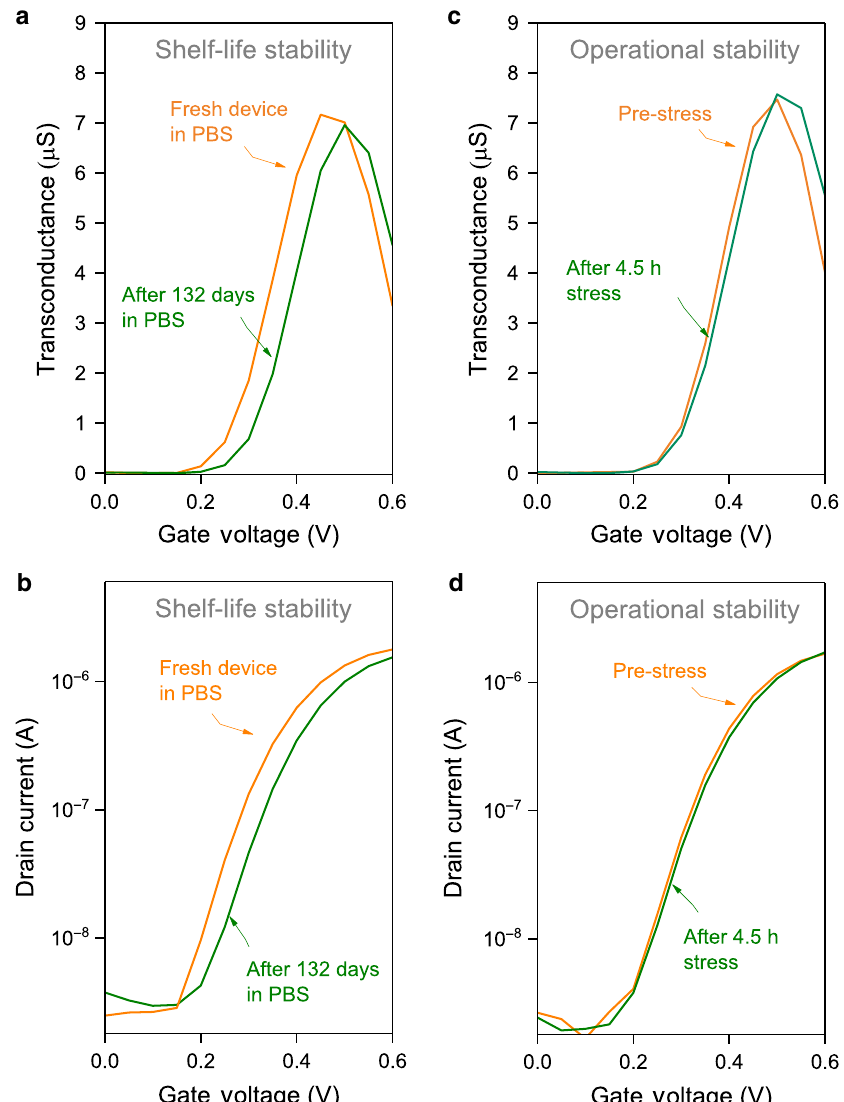
Fig. 5 Organic electrochemical transistor stability. a Transconductance and ( b ) transfer characteristics demonstrating the shelf-life stability of best- performing P-90:TBAF(40 mol%) organic electrochemical transistors, after being submerged in phosphate-buffered saline (PBS) solution for 132 days. c Transconductance and ( d ) transfer characteristics of P-90:TBAF(40 mol%) organic electrochemical transistors before and after V G = 0.4 V pulsed at 10 s intervals for 4.5 h, demonstrating the operational stability of the best-performing n-doped system, where V D = 0.4